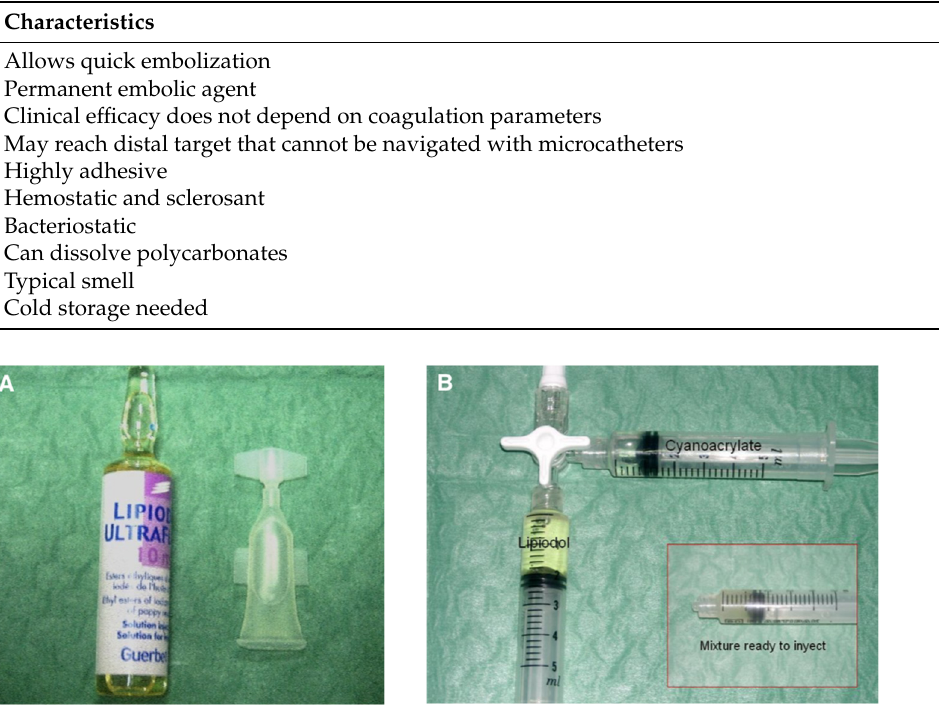
Figure 4. Features and preparation of glue and lipiodol as a mixture before embolization. ( A ) Lipiodol ® 10 mL vial and Glubran ® 2 1 mL vial. ( B ) Preparation of the glue/lipiodol mixture with 2 separated 5 mL plastic luer-locked syringes and a plastic 3-way stopcock in a smooth manner.